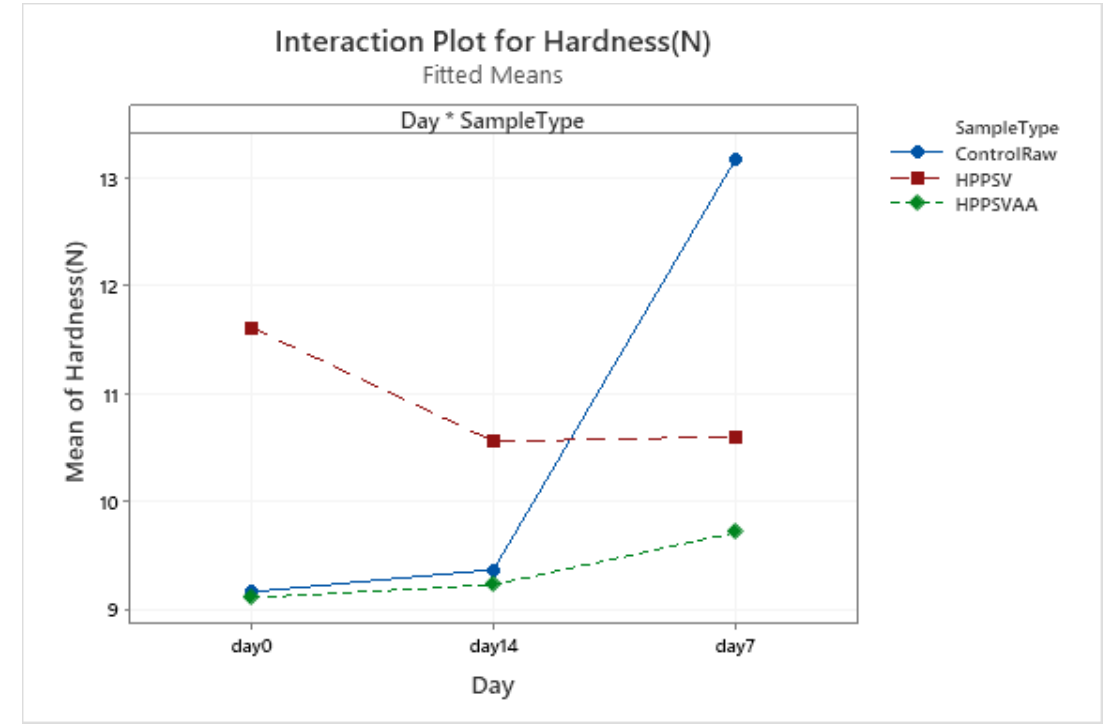
Figure A4 . Effect of treatments and storage time on the chewiness of veal patty (HPPSV: HPP- SVCOOK).